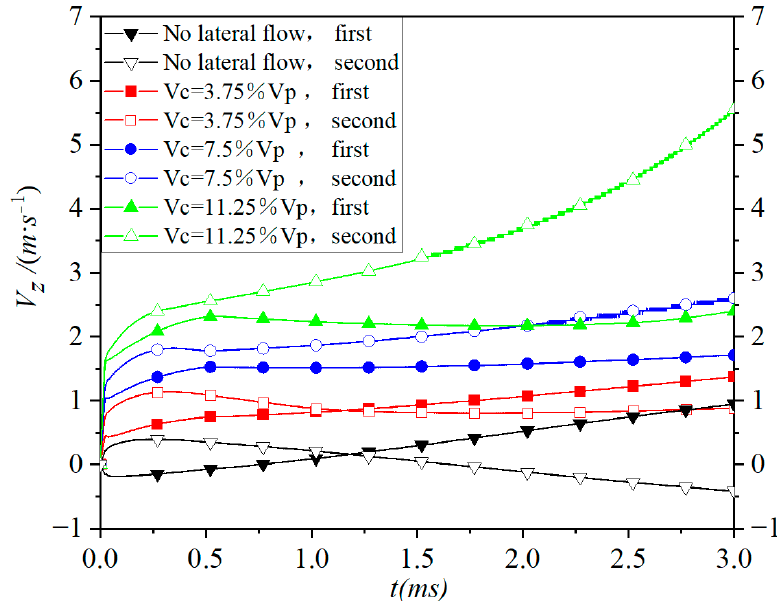
Figure 14. The change in the offset velocity of the projectiles in the z-direction.